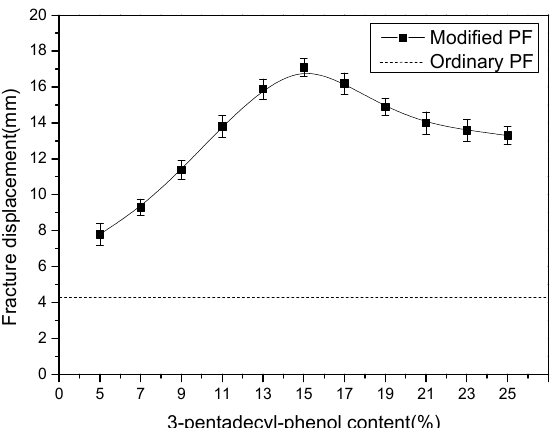
Figure 6. The effect of 3-pentadecyl-phenol with different contents on the bending deflection of the foam.